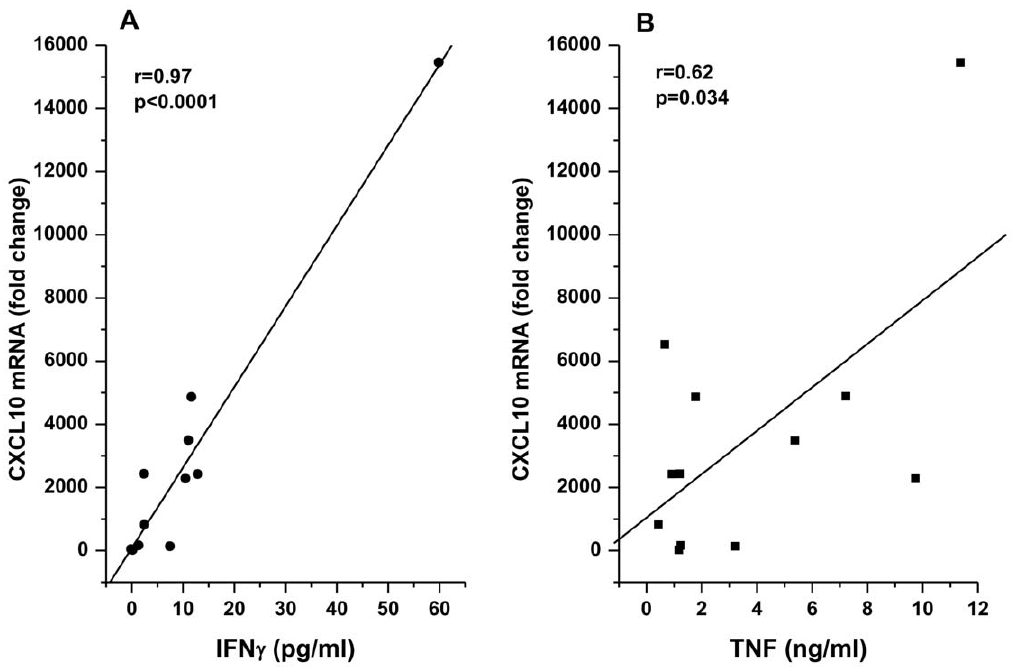
Figure 5. Epithelial CXCL10 mRNA induction is proportional to the amounts of IFN c and TNF produced by T cell clones. HNEC were co-cultured with T cell clones obtained from PBMC of a normal individual. CXCL10 mRNA induction is expressed as a function of IFN c (A) and TNF (B) secreted by T cell clones in the culture medium. Epithelial CXCL10 mRNAs are measured by real-time PCR and expressed as fold increase relative to those measured in epithelial cells cultured without T cells. IFN c and TNF were measured by TenPlex bead immunoassay and ELISA.